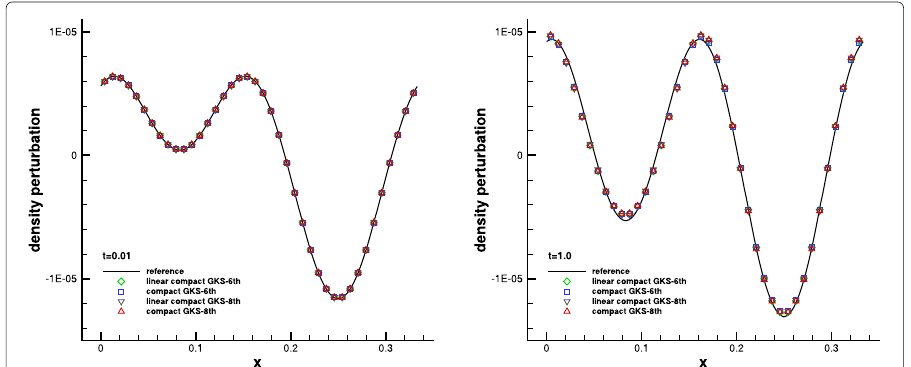
Fig. 9 One-dimensional acoustic problem: the distributions of density perturbation obtained by compact GKS at t = 0.01 (left, 1 period) and t = 1.0 (right, 100 periods) with 40 mesh points